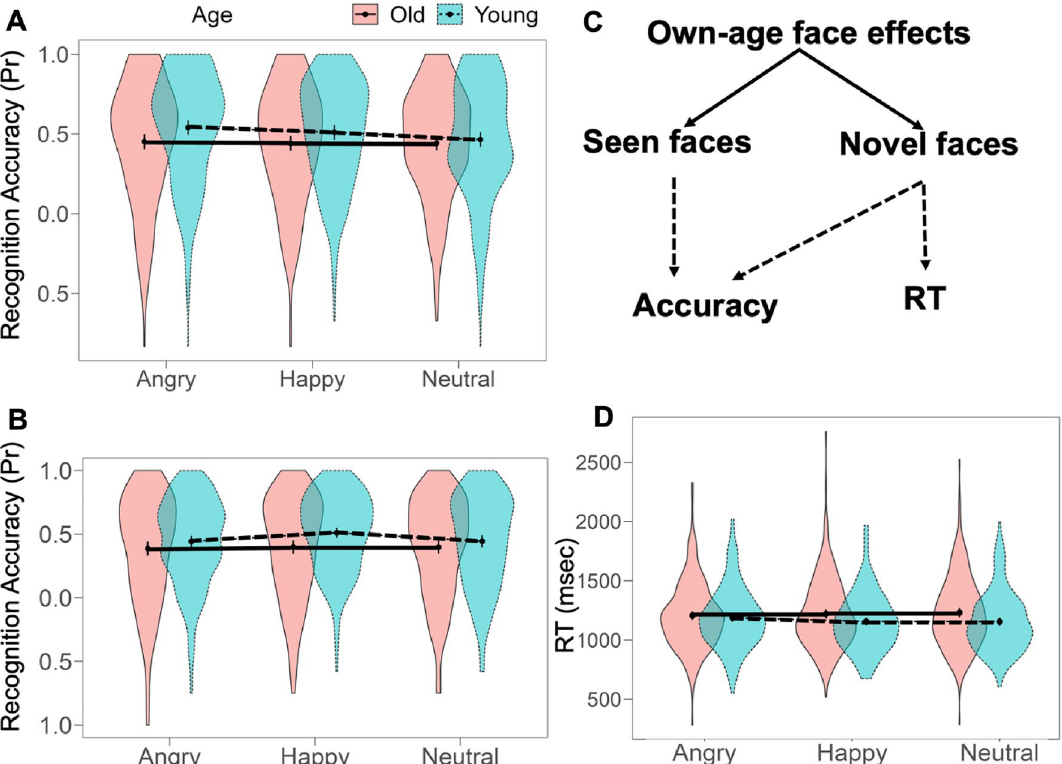
Figure 2. Violin plots depicting the Own Age Bias in recognition accuracy for Seen ( A ) and Novel faces ( B ), and response time for Novel faces ( D ). The black dots represent means of the estimates with 95% confidence intervals. Panel ( C ) represents a schematic summary of the measurements showing the own-age biases in